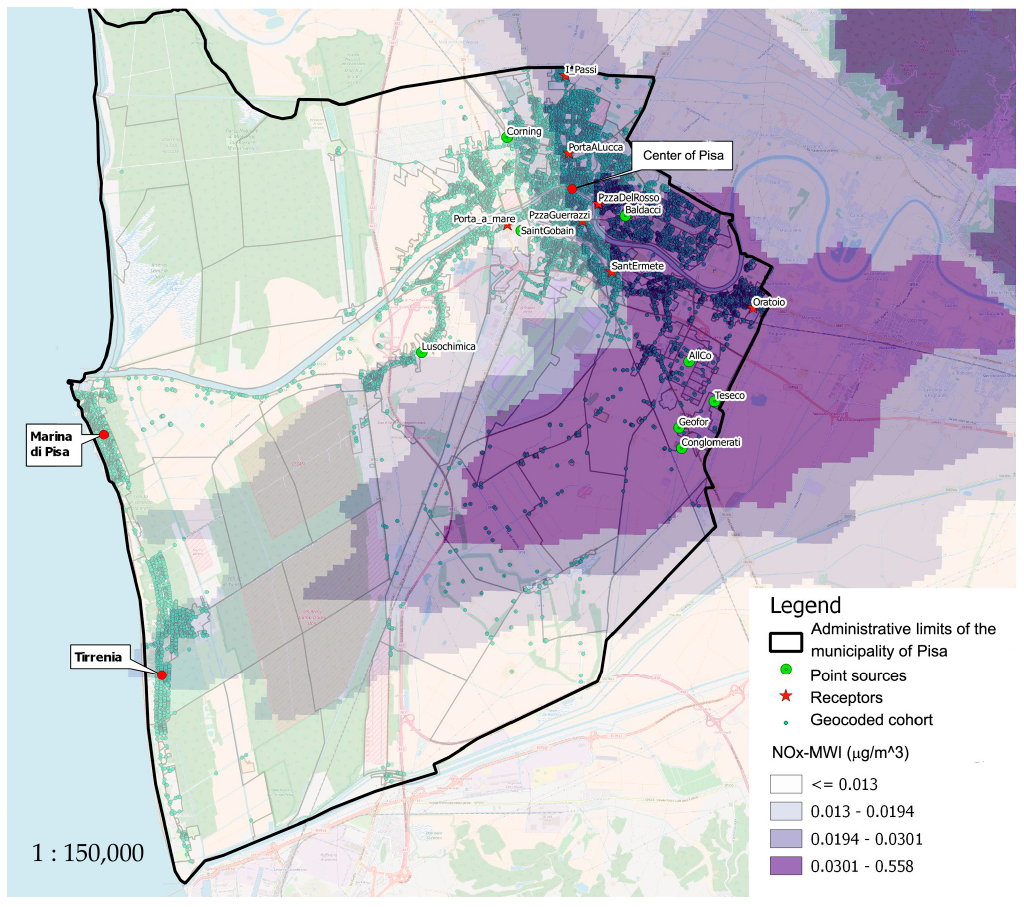
Figure 1. The study area.